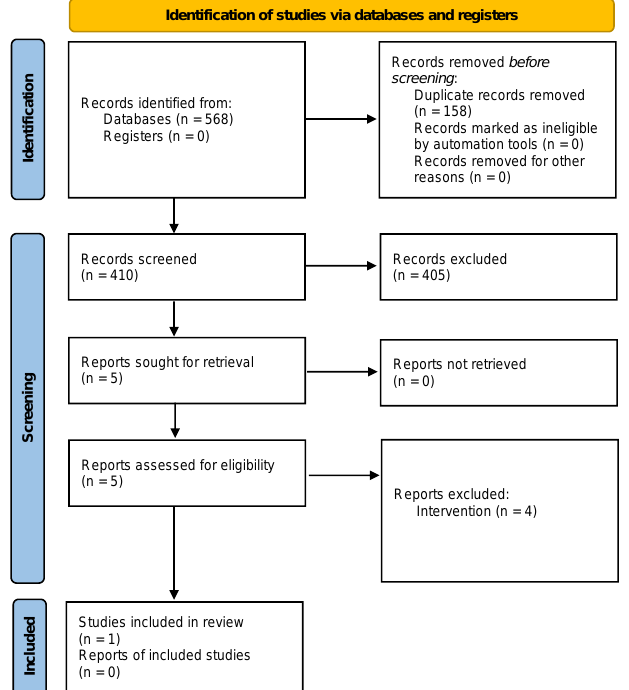
Figure 1. Flow diagrams of literature review for vulvodynia. This figure was adapted from the Preferred Reporting Items for Systematic Reviews and Meta-Analyses (PRISMA) statement.